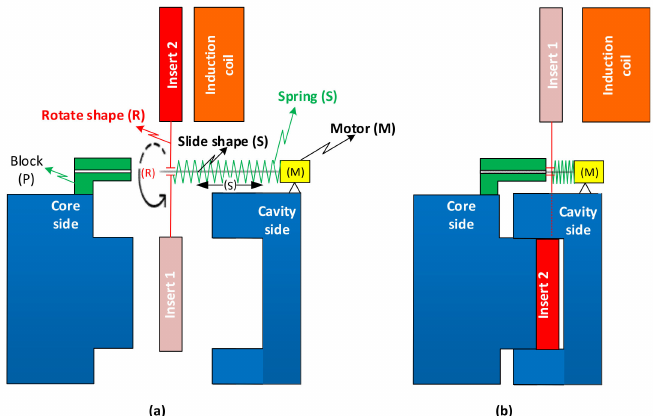
Figure 1. The principle of rotation structure with the position of mold open ( a ) and mold closed ( b